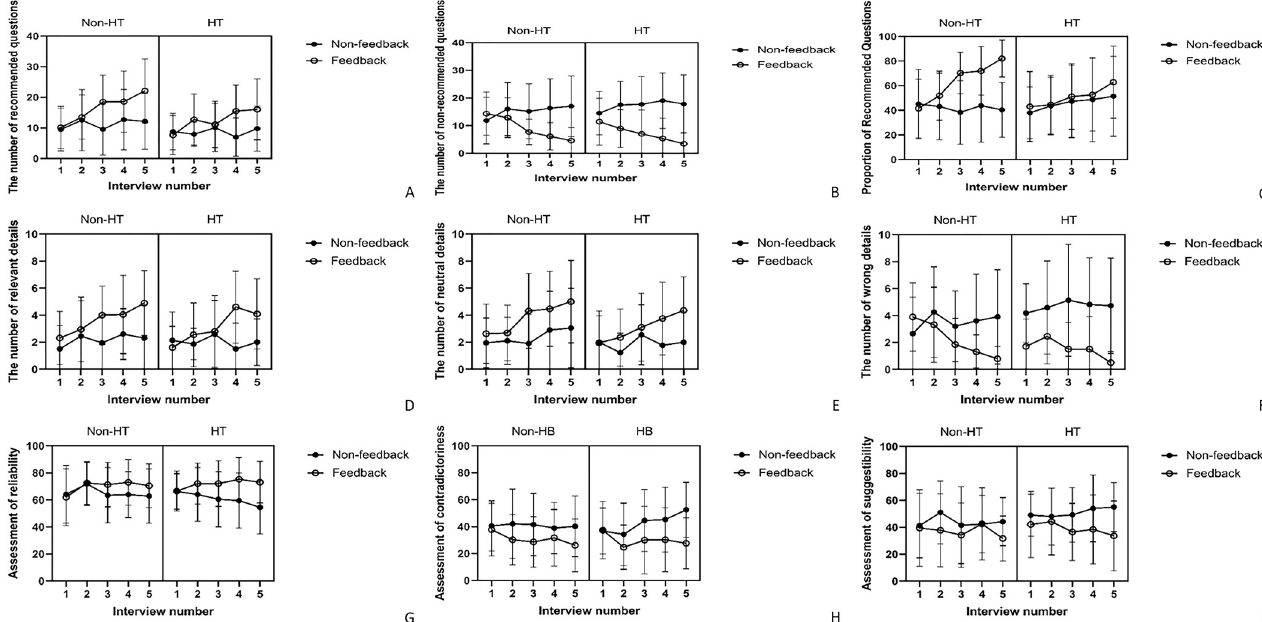
Fig 1. Question skills, types of details, and the assessment of information from Avatars in different number of interviews among different combinations of two interventions. HT: Participants who built hypotheses before each interview. Feedback: Participants who received feedback on outcome and question types. Panels (A): The means of recommended questions (B) the means of non-recommended questions, and (C) the mean proportions of recommended questions presented by participants in different number of interviews. Panels (D) The means of relevant details, (E) neutral details, and (F) wrong details presented by participants in different number of interviews. Panels (G) The averaged degree of reliability (H) contradictoriness, and (I) suggestibility of information from avatars assessed by participants in different number of interviews.